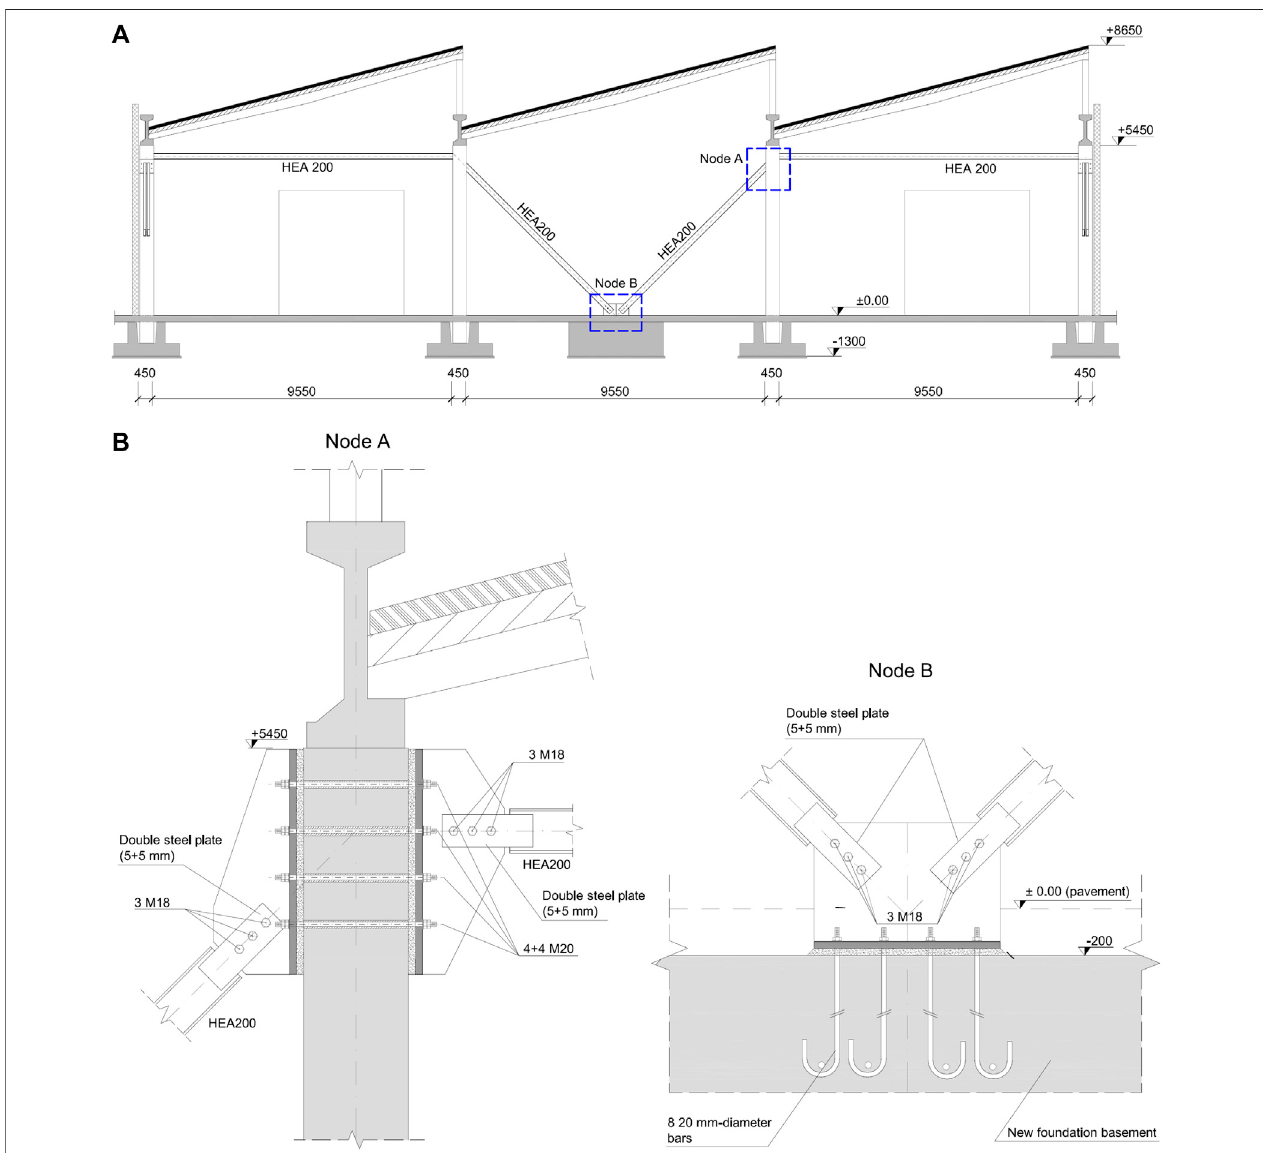
FIGURE 8 | V-shaped steel bracing used to stiffen four columns in a precast building with shed-type roof: (A) front view; detail view of (B) bracing-to-column and (C) bracing-to-foundation nodes. Dimensions in mm.